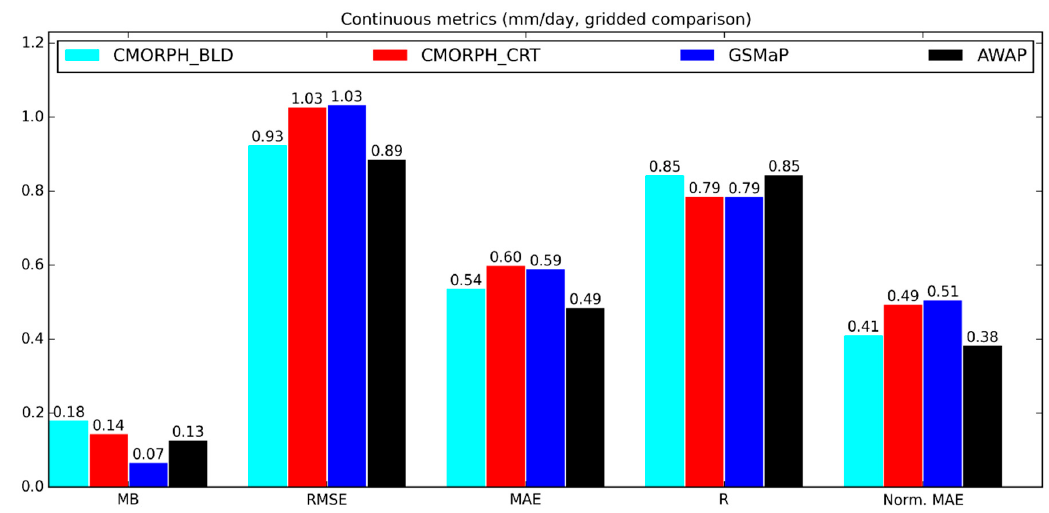
Figure 10. Point-based comparison categorised by rainfall intensities from January 2001 to December 2018 using station gauges as truth. Occurrence frequencies, cumulative volumes, mean average error (MAE), and normalised MAE are displayed.